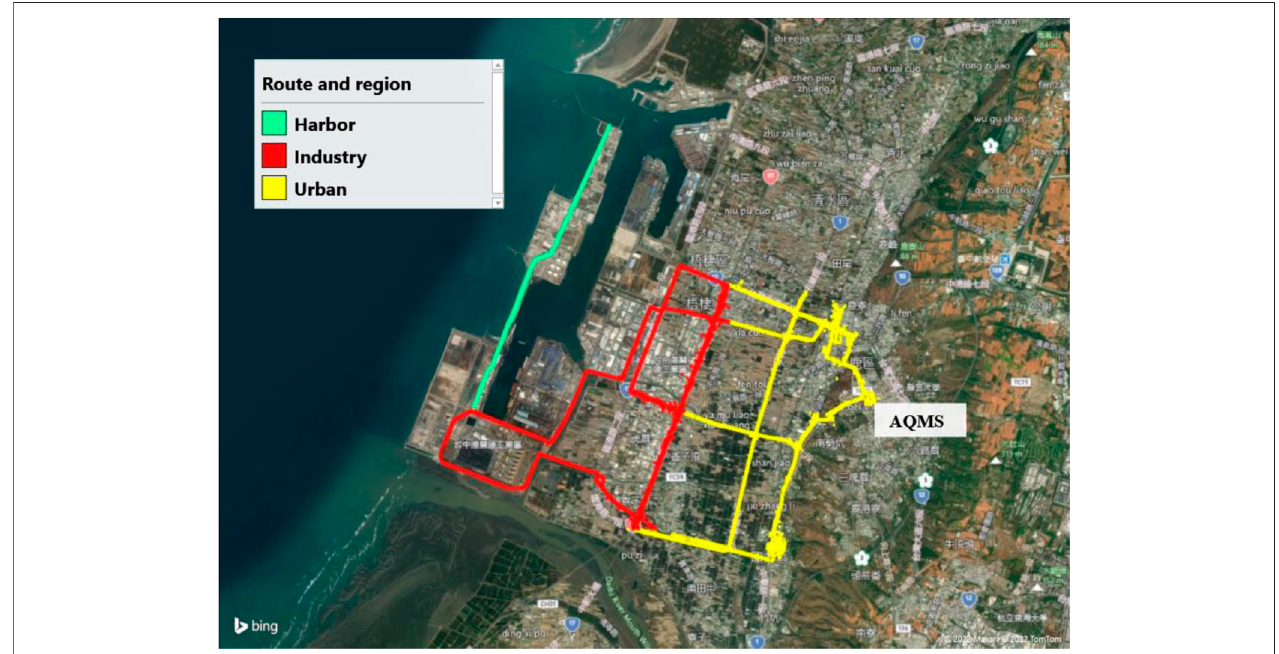
FIGURE 2 | MMS sampling route in the three regions: urban (yellow), industrial (red), and harbor regions (green).